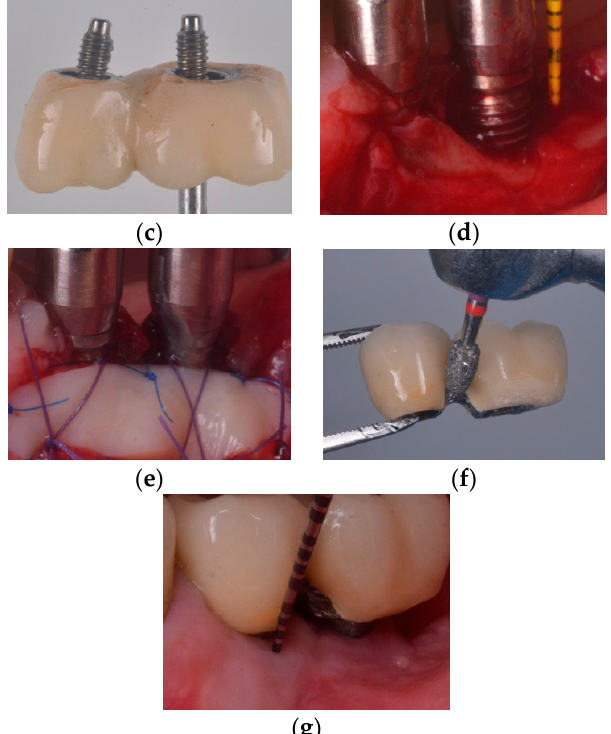
Figure 6. ( a ) Clinical presentation of peri-implantitis; ( b ) Radiographic image compatible showing moderate (<50%) bone loss; ( c ) Inadequate prosthesis emergence profile; ( d ) Partial-thickness apical position flap; ( e ) Soft tissue conditioning by means of free epithelial graft; ( f ) Prosthesis contour modification to facilitate proximal access during self-performed oral hygiene; ( g ) Clinical resolution of peri-implantitis associated with a gain of keratinized mucosa.